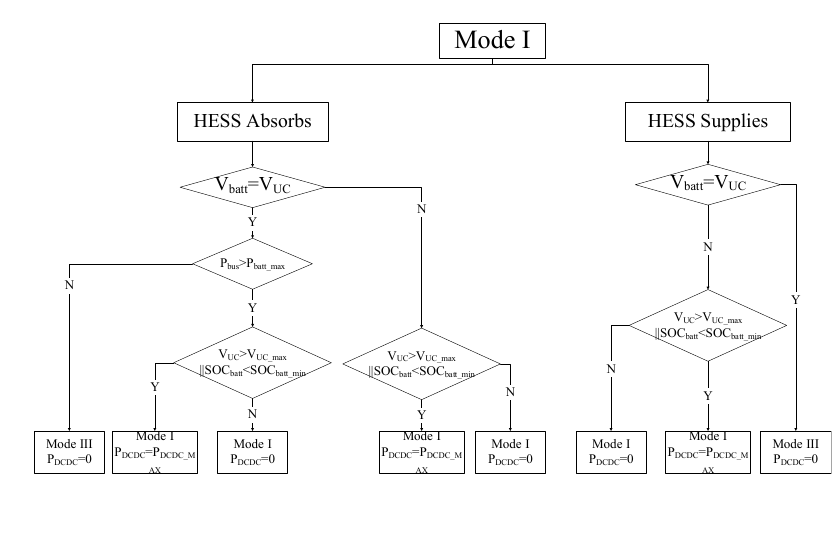
Figure 8. Control flowchart for Mode I.